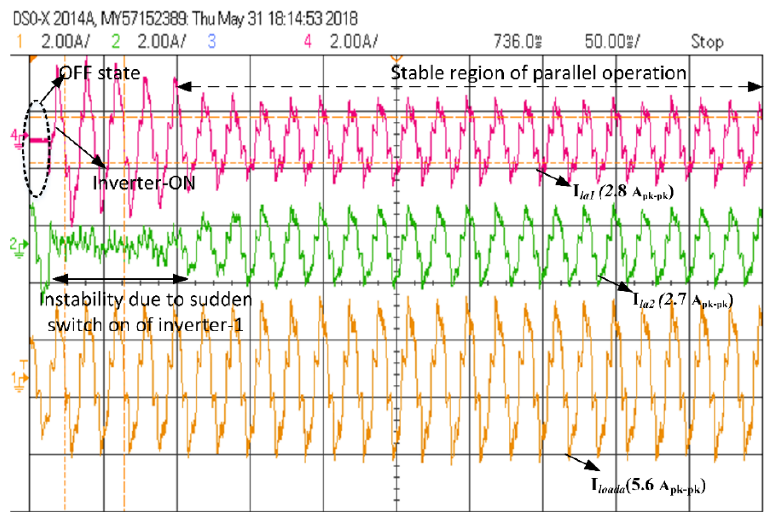
Figure 30. Current sharing during sudden switch on of the inverter.